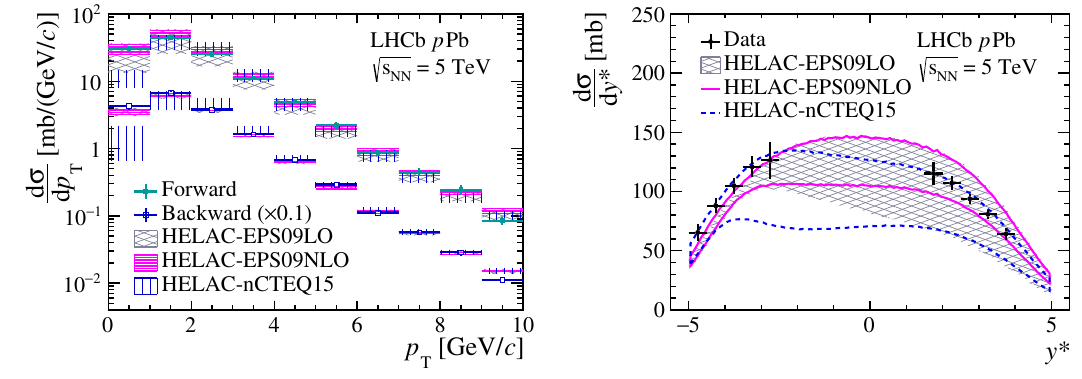
Figure 4 . Di(cid:11)erential cross-section of prompt D 0 meson production in p Pb collisions as a function of (left) p T ( d (cid:27) ) and (right) y (cid:3) ( d (cid:27) ) in the forward and backward collision samples. The uncer- d p T d y (cid:3) tainty is the quadratic sum of the statistical and systematic components. The measurements are compared with theoretical predictions including di(cid:11)erent nuclear parton distribution functions as explained in the